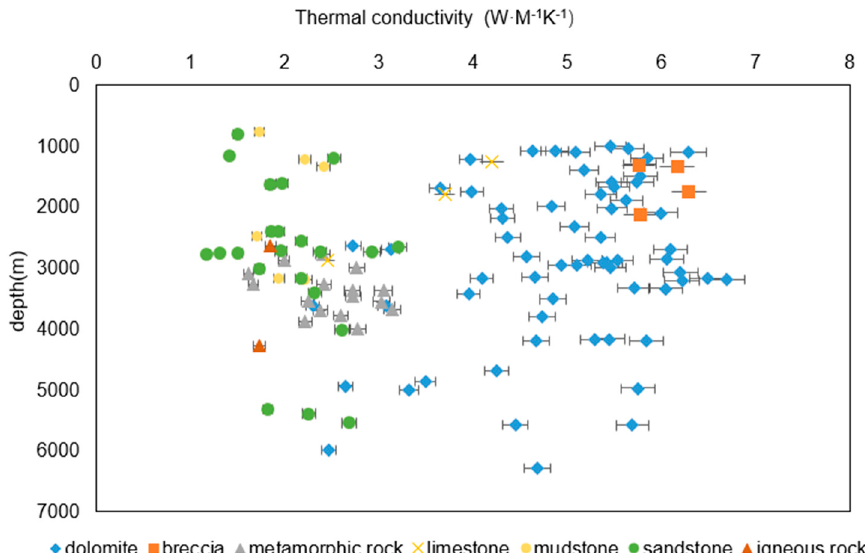
Figure 12. Relationship between the thermal conductivity and depth of different lithologies.